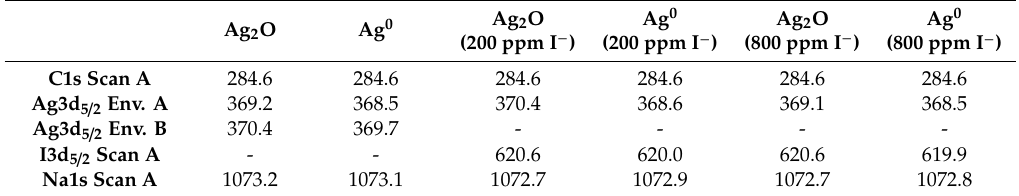
Table 6. XPS binding energy results (eV).